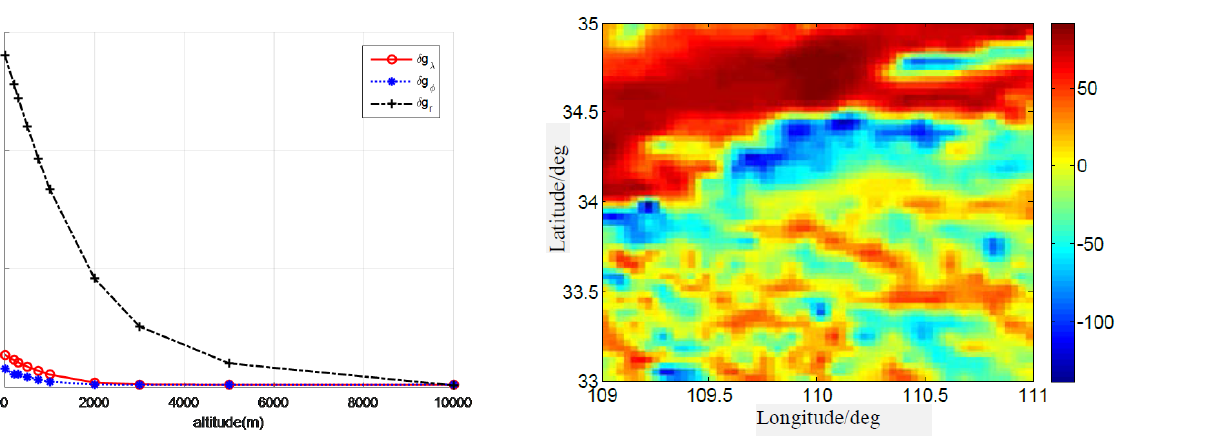
Fig. 5. difference of δg r between classical Stokes integral values and true values at altitude near 0 m